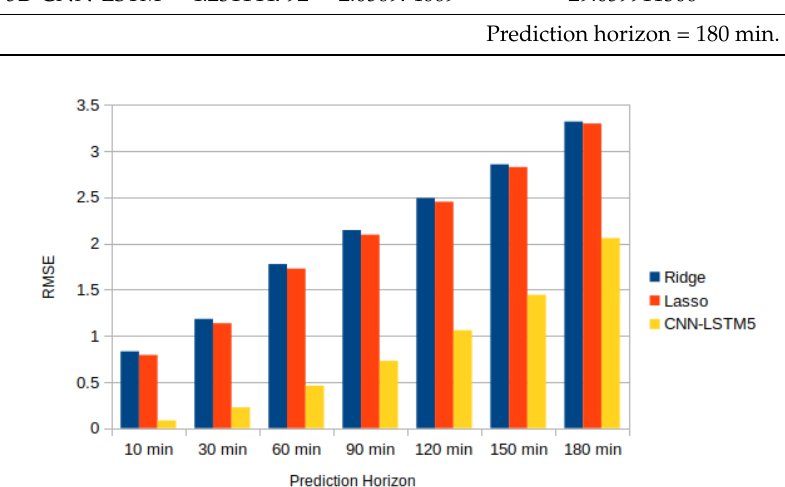
Figure 13. RMSE statistics for various forecasting